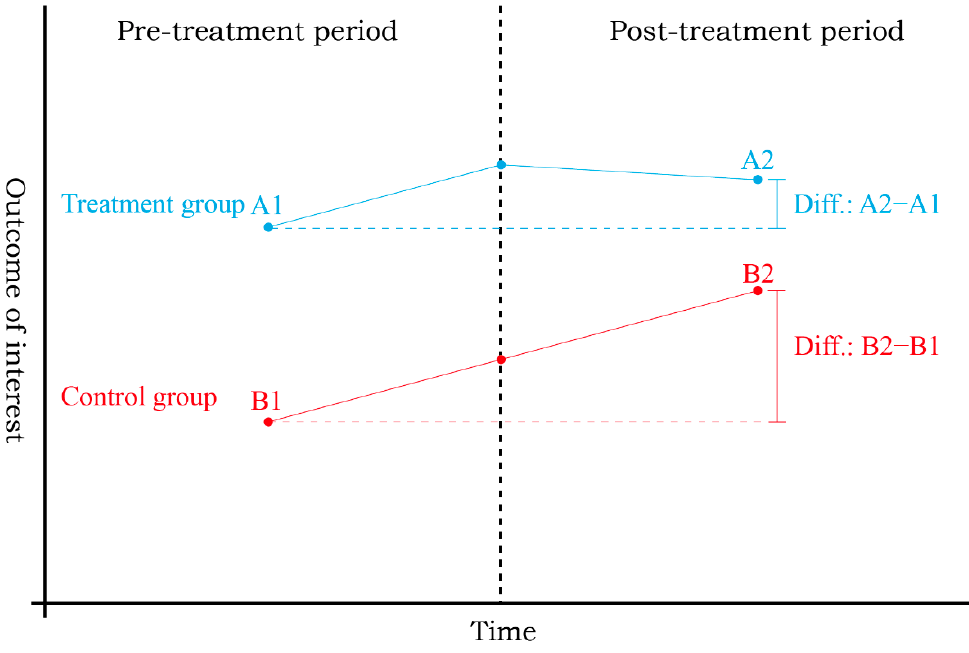
Figure 2. Conceptual illustration of the DID approach.